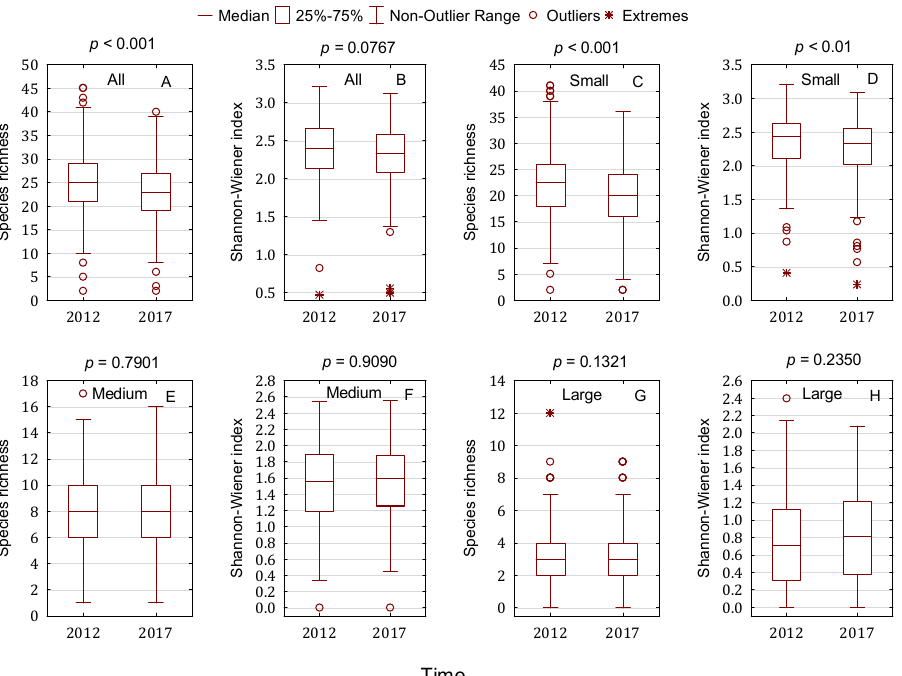
Figure 4. Changes in community diversity parameters in relation to forest succession. DBH classes are defined according to the tree size, as follows: All ( A and B ), All trees; Small ( C and D ), 1 cm ≤ DBH < 7.5 cm; Medium ( E and F ), 7.5 cm ≤ DBH < 22.5 cm; Large ( G and H ), 22.5 cm ≤ DBH.